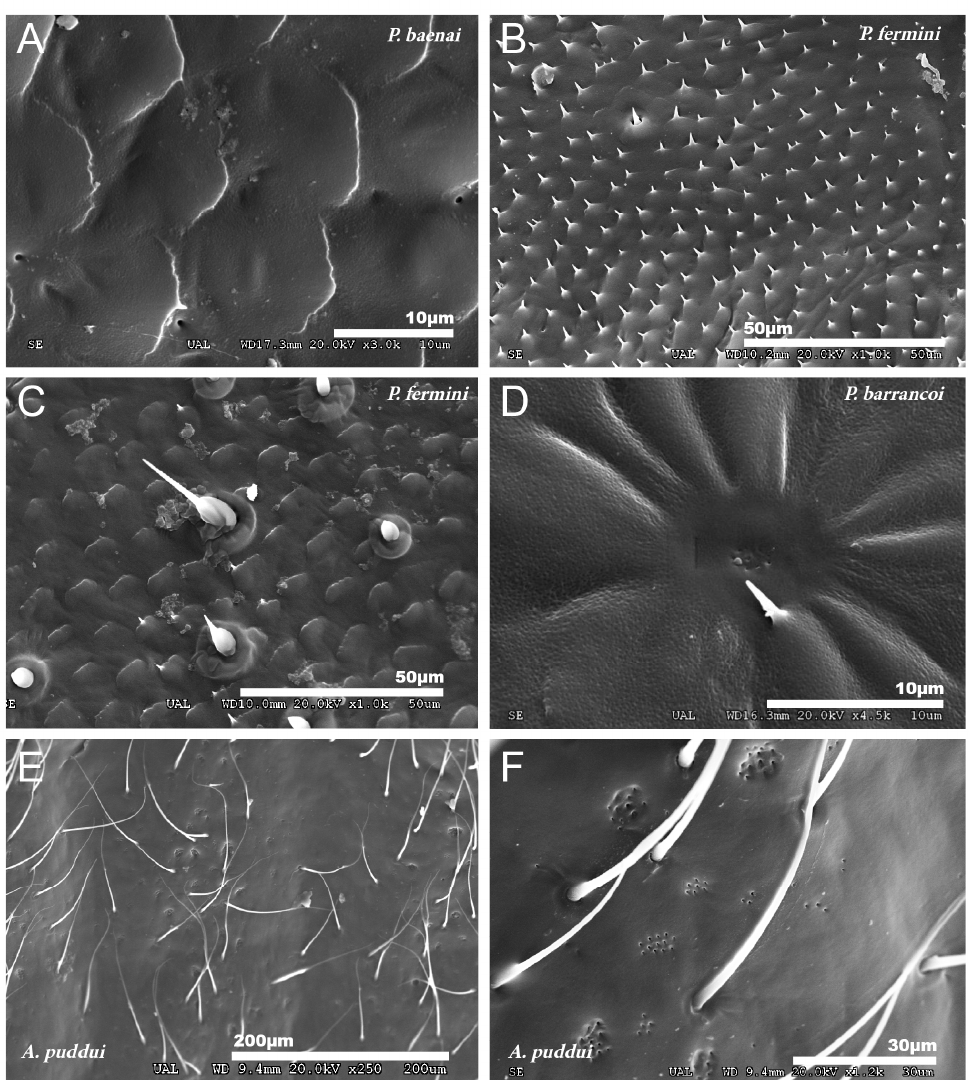
Figure 5. Ventral side of tegmina. ( A ) Less polyhedric design and spiniform than dorsally in P. baenai and punctually developed in P. fermini ( B ). ( C ) Ampuliform setae in P. fermini . ( D ) Pore array in a radial pattern of diffusion grooves in P. barrancoi . ( E ) Ventral surface of A. puddui ; smooth and irregular with finer and longer setae than dorsally. Pores are highly developed in this genus and appear punctually in clusters integrated into concavities like those observed in the SEM image of A. puddui ( F ).